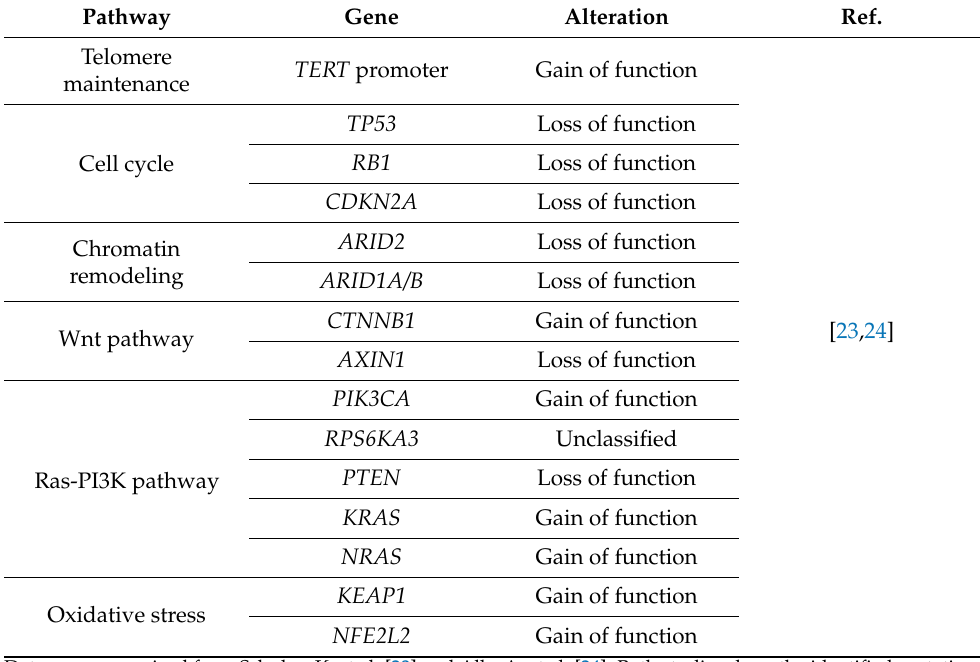
Table 1. Altered cancer driver genes in hepatocellular carcinoma. Pathway Gene Alteration